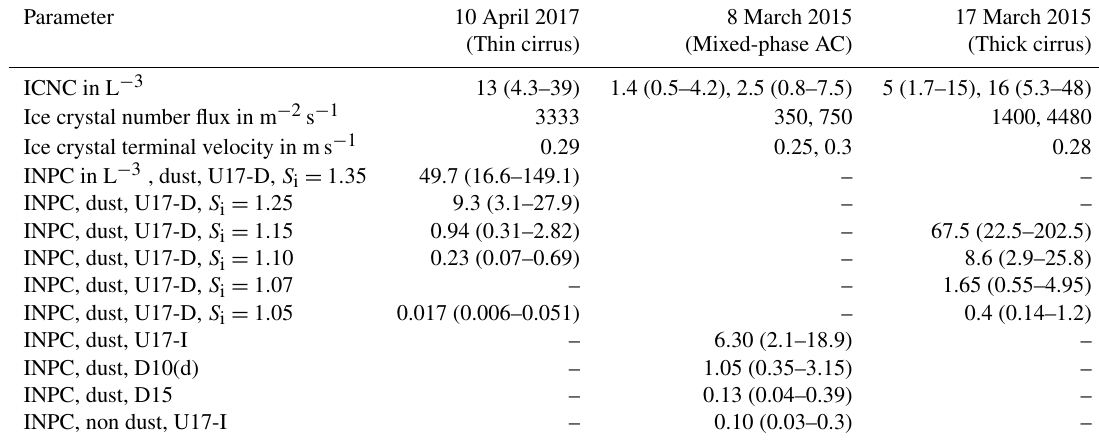
Table 2. Overview of ICNC and INPC retrieval results for the three closure studies on 10 April 2017 (CyCARE) and 8 and 17 March 2015 (Cyprus-2015 campaign). The vertical ice crystal number flux is the most direct observation and was determined from the combined information of the terminal velocity of the falling ice crystals, the radar reflectivity, and the lidar backscatter coefficient. The ICNC is obtained from the ratio of the ice crystal number flux to the terminal velocity. The listed INPC values are maximum values found within the upper part of the cloud layer, i.e., at 8.4km height on 10 April, at 9.8km height on 17 March, and at 5.8km height on 8 March 2015. All INPC and ICNC values are given with an uncertainty range of about a factor of 3 (in parentheses).